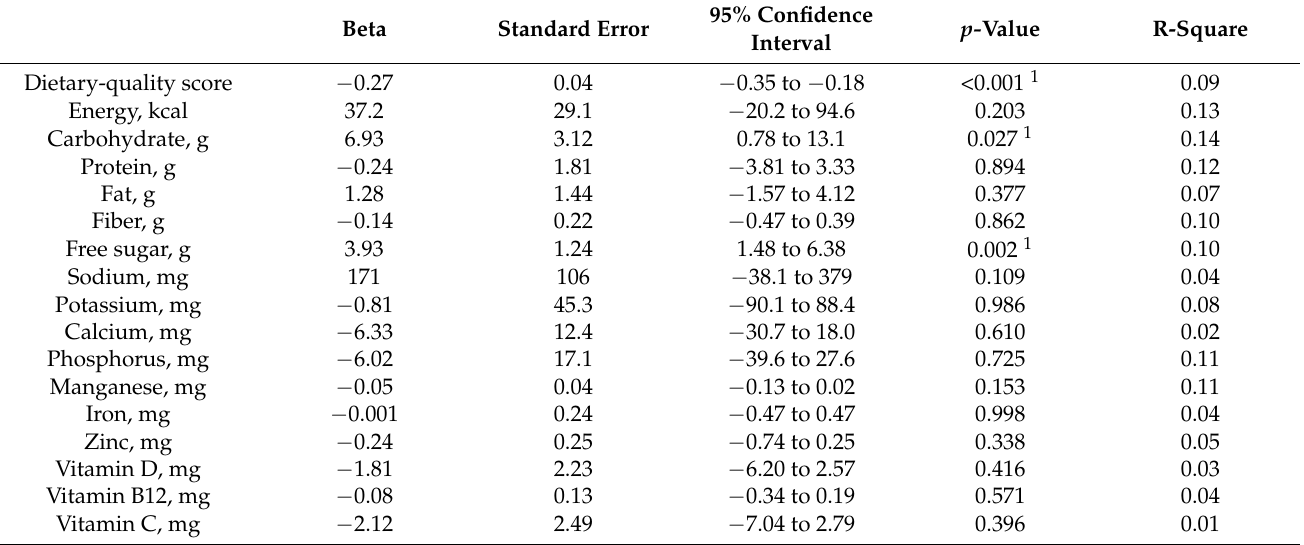
Table 3. Multiple linear regression analysis of dietary quality and dietary intake in relation to fast-food consumption among adolescents in Saudi